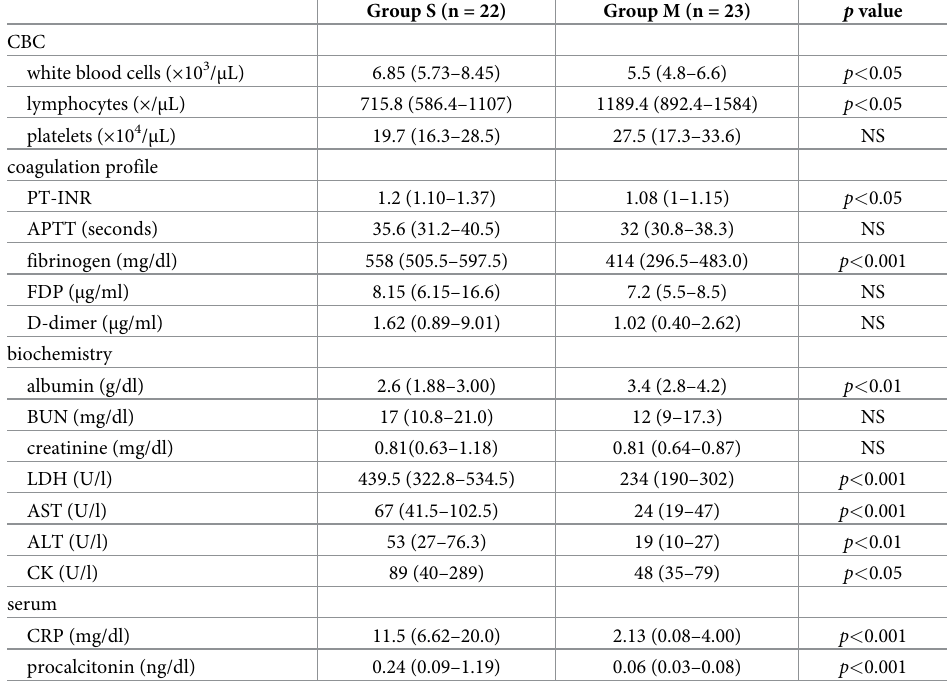
Table 2. Laboratory findings on admission of the patients with COVID-19 pneumonia comparing severe with moderate cases. Group S (n = 22) Group M (n =